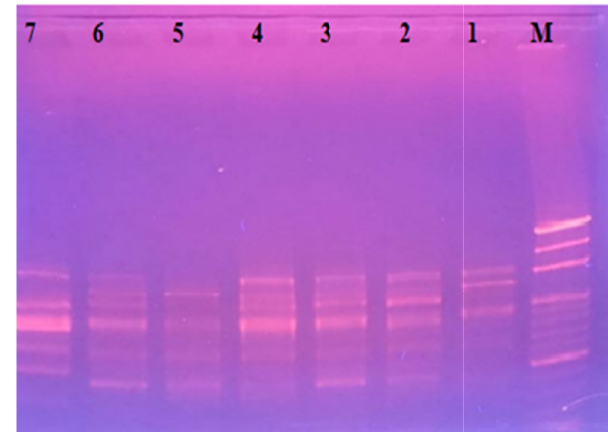
Fig. 2. ISSR-PCR gel